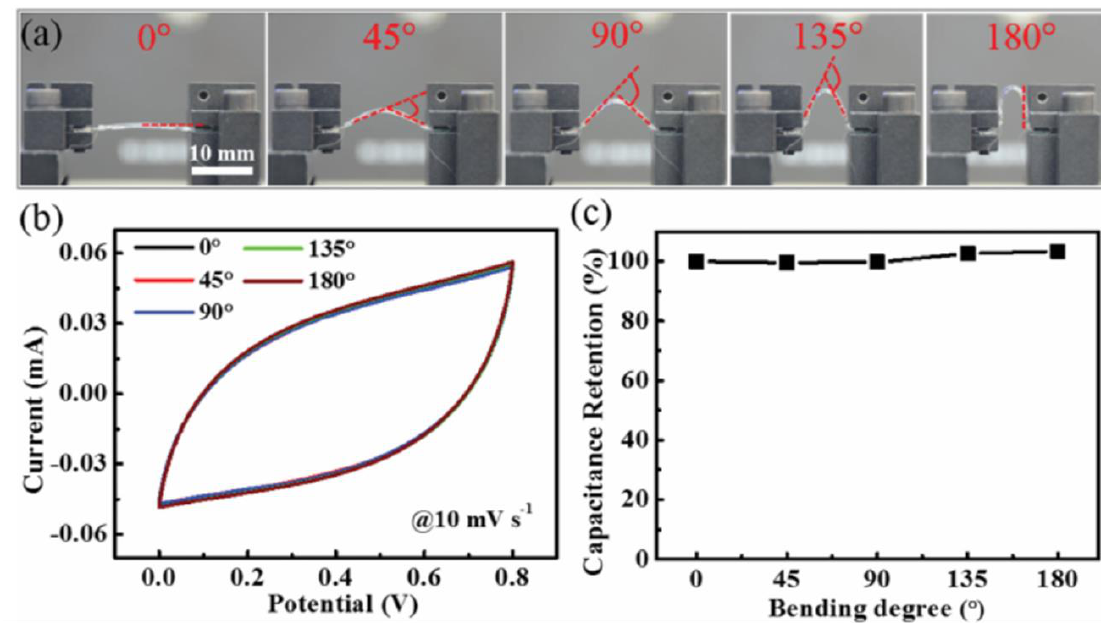
Figure 3. ( a ) Digital illustrations of a parallel double helix structure (PDHS) in different bent states. ( b ) Corresponding CV graphs and ( c ) the capacitive retention property at different bent states. Adapted with permission from [47]. Copyright (2016), WILEY-VCH Verlag GmbH & Co. KGaA, Weinheim.